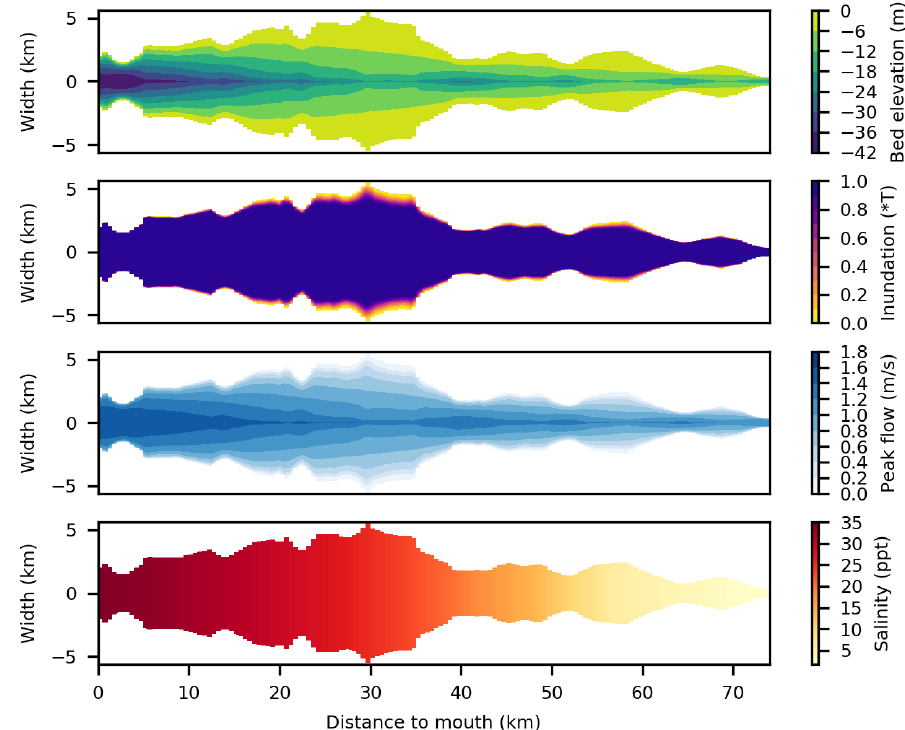
Figure 6. Resulting predictions of bed elevation with respect to the high water level, inundation duration, peak flow velocity and salinity for the Columbia